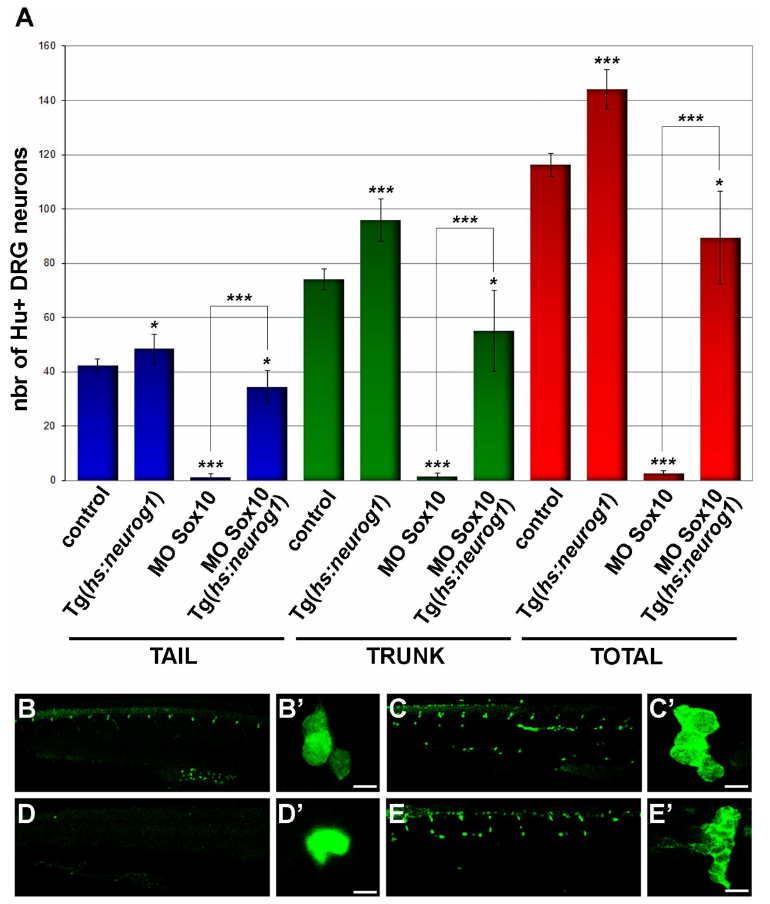
Fig 9. Global mis-expression of Neurog1 is sufficient to phenocopy the baz1 mutant DRG phenotype. (A) Quantificationof mean ( ± s.d.) total numbers of Elav1/Hu+DRG neuronsin tail (blue), trunk (green)or total (red). The numberof embryos analysedwas 6 (WT control), 6 ( hs : ngn1 ), 8 (MO sox10 )and 7 (MO sox10 , hs : ngn1 ). Significance of differences as determinedby two-tailed Student’s t test comparisons is indicatedby * (p < 0.05), ** (p < 0.001)and *** (p < 0.0005). Control (B-C’) or sox10 -morpholinoinjected (D-E’) embryos were left uninduced (B,B’,D,D’) or subjectedto heat-shock (C,C’,E,E’) and subsequently processedfor Elav1/Hu immunofluorescenceat 5 dpf; embryos were heat-shocked at 28hpf for 1 hour. Panelsshow lateral views of trunk (B,C,D,E) and close-upsof representative DRGs